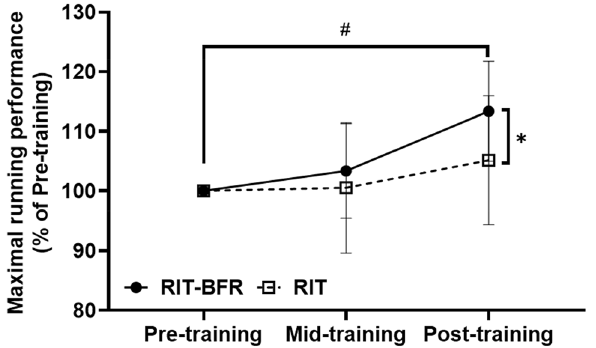
Figure 2. The percentage changes on maximal running performance after training. Statistical testing: Two- way ANOVA (repeated measures) with Bonferroni post hoc test; Data is displayed as mean ± SD. Significant differences were shown ( # p < 0.05, compared with pre-training; and * p < 0.05, compared with the RIT group).